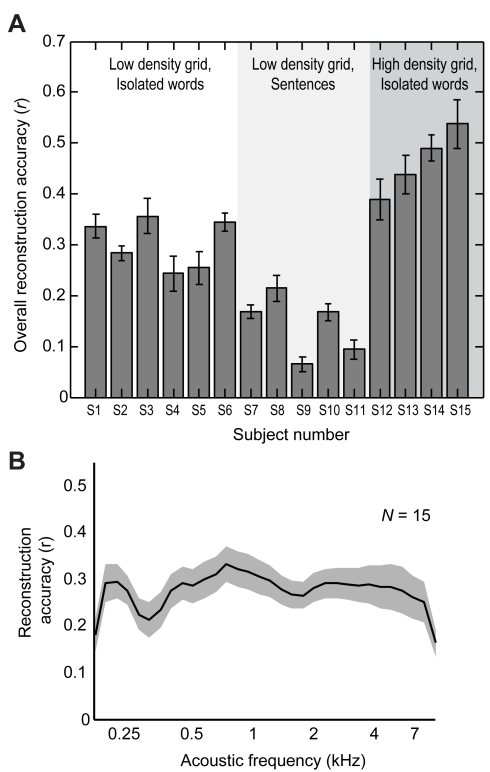
Individual participant and group average reconstruction accuracy.(A) Overall reconstruction accuracy for each participant using the linear spectrogram model. Error bars denote resampling SEM. Overall accuracy is reported as the mean over all acoustic frequencies. Participants are grouped by grid density (low or high) and stimulus set (isolated words or sentences). Statistical significance of the correlation coefficient for each individual participant was computed using a randomization test. Reconstructed trials were randomly shuffled 1,000 times and the correlation coefficient was computed for each shuffle to create a null distribution of coefficients. The p value was calculated as the proportion of elements greater than the observed correlation. (B) Reconstruction accuracy as a function of acoustic frequency averaged over all participants (N = 15) using the linear spectrogram model. Shaded region denotes SEM over participants.